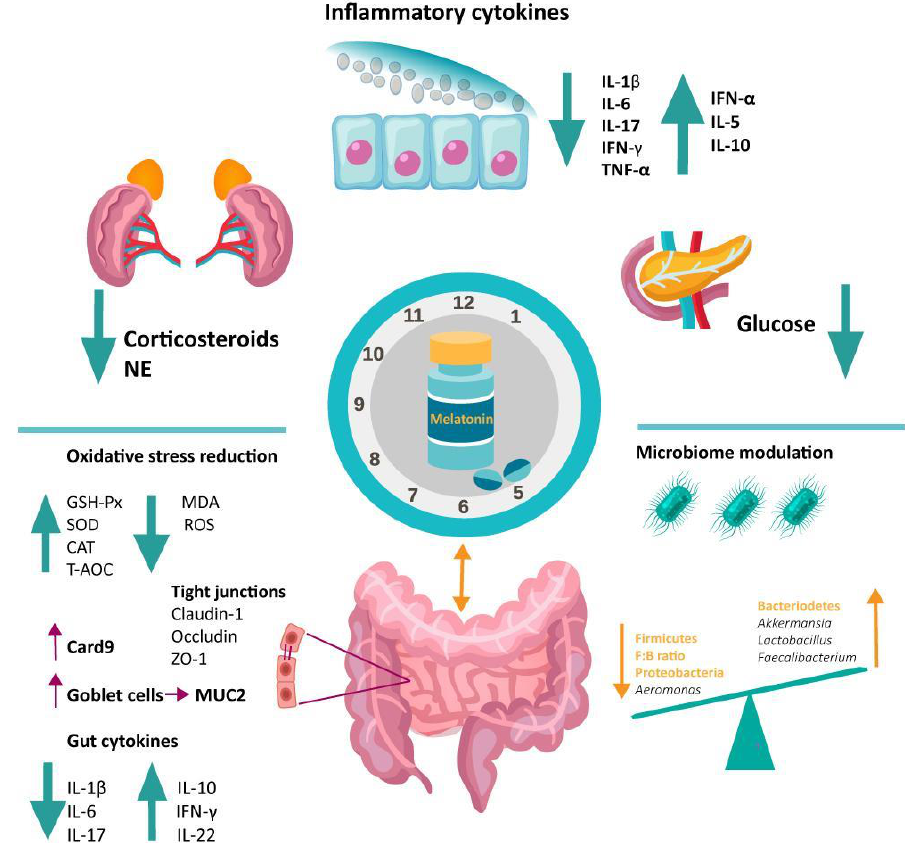
Figure 3. Melatonin’s beneficial systemic and GI effects in sleep disorders. In the gut, melatonin: (i) reestablishes the intestinal microbiome—decreases the Firmicutes to Bacteroidetes ratio and Proteobacteria at the phylum level; increases Akkermansia, Lactobacillus, and Faecalibacterium ; and decreases Aeromonas at the genus level; (ii) restores the barrier integrity by increasing tight junction proteins (claudin-1, occludin, ZO-1), goblet cell numbers (MUC2), and CARD9; (iii) reduces the oxidative stress by increasing the levels of the antioxidant enzymes (GSH-Px, SOD, CAT), T-AOC and decreasing MDA, ROS; (iv) diminishes the inflammatory state by decreasing the proinflammatory cytokine (IL-1ß, IL-6, IL-17) and increasing anti-inflammatory ones (IL-10, IFN- γ , IL-22). At the systemic level, melatonin: (i) reduces the stress hormones (corticosterone, NE); (ii) diminishes the inflammatory systemic state by decreasing the inflammatory cytokines (IL-1 β , IL-6, IL-17, TNF- α , INF- γ ), and increasing the anti-inflammatory ones (IL-5, IL-10, IFN- α ); (iii) restores glucose homeostasis by decreasing the glucose levels. Abbreviations: ↑ , Increase; ↓ , Decrease; ZO-1, Zonula Occludens-1; MUC2, Mucin 2, oligomeric mucus gel-forming; GSH-Px, glutathione peroxidase; SOD, superoxide dismutase; CAT, catalase; T-AOC, total antioxidant capability; MDA, malondialdehyde; ROS, reactive oxygen species; TNF- α, tumor necrosis factor - α; IL, interleukin; IFN- γ, interferon γ; CARD9, Caspase Recruitment Domain Family Member 9; NE, norepinephrine.